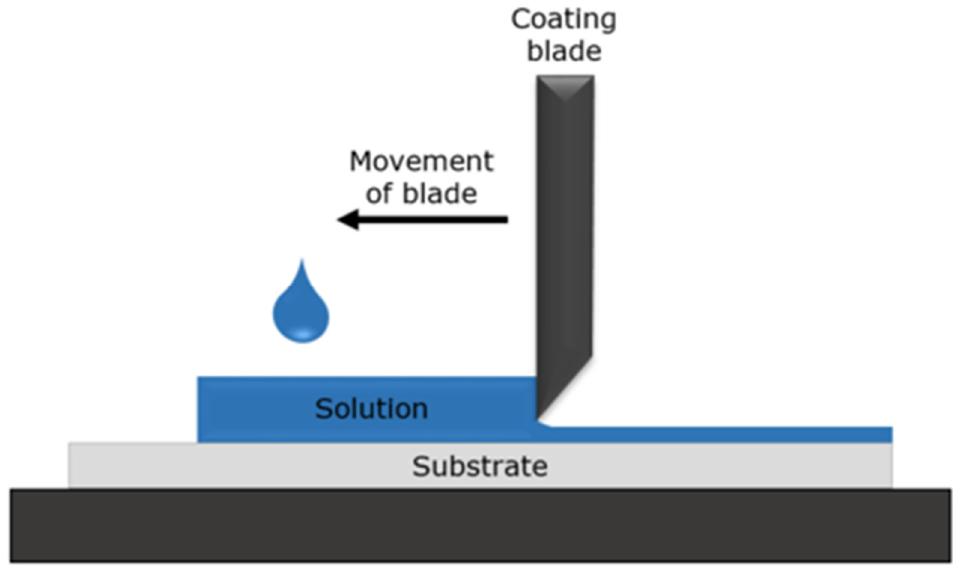
Figure 9. Schematic representation of blade coating printing technique [95].